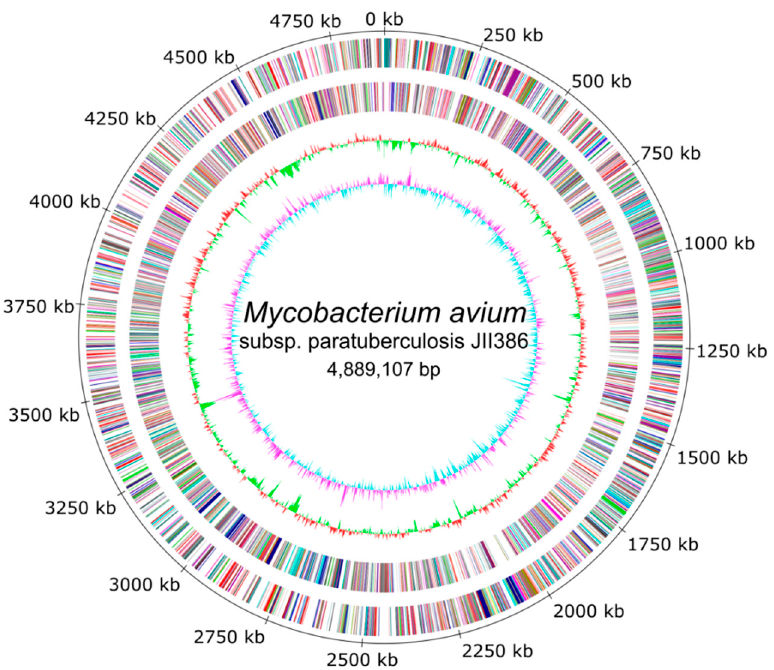
Figure 1. Circular map of sheep isolate JIII-386. The circles represent (from innermost to outermost) GC skew and GC content (in blue and green: values below the average; in purple and red: values above the average), predicted protein coding sequences (CDS) transcribed anticlockwise (inner part) or clockwise (outer part), and genomic position in kb. The CDSs are colored according to the assigned clusters of orthologous groups (COG), [67]. The gene dna A is localized at the 0 kb